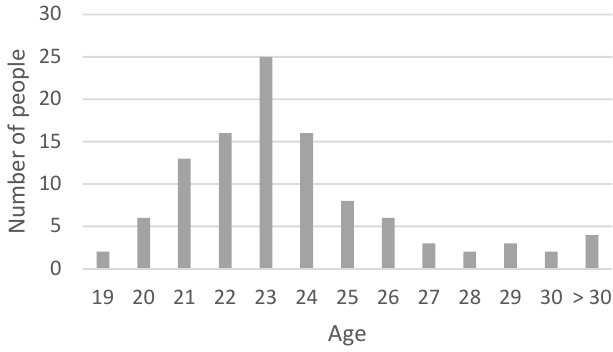
Figure A1. Age distribution in the population, first survey (106 Figure A1 . Age distribution in the population, first survey (106 individuals).